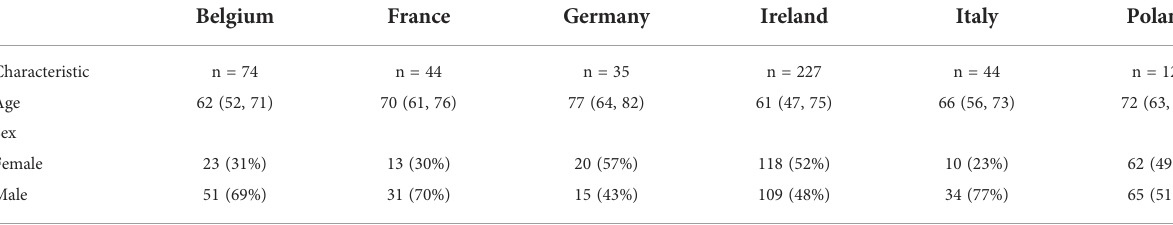
TABLE 1 Age and sex of patients enrolled strati fi ed by